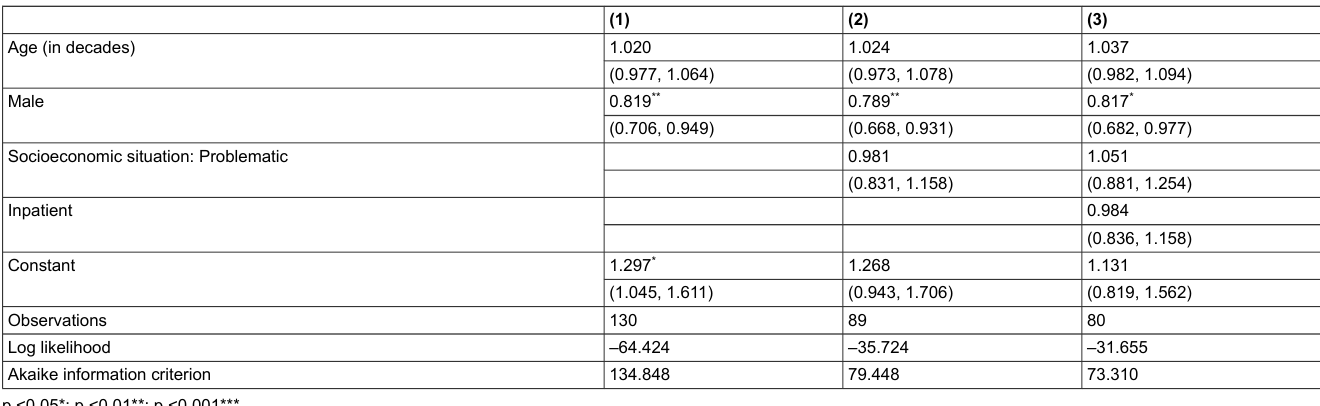
Table 7: Logistic regressions on the response : “Suicide method = Jump from a height”.